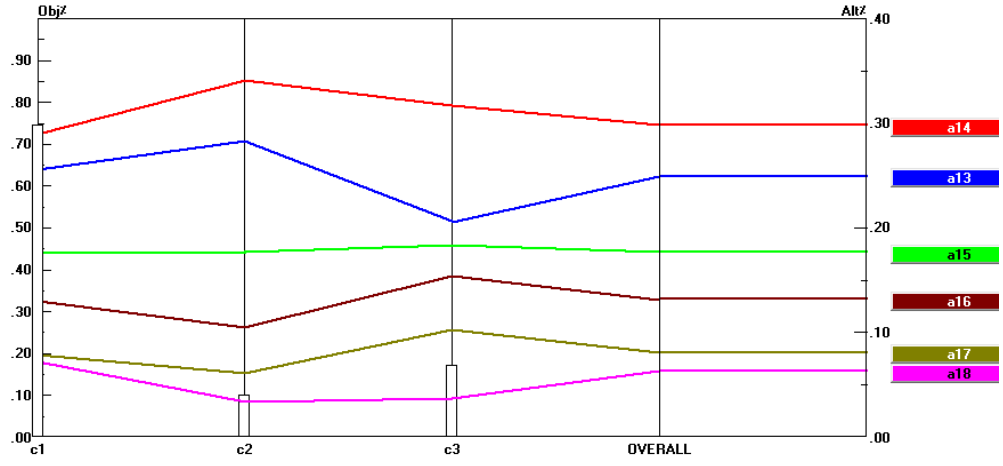
Fig. 7. The sensitivity analysis of indicators and suppliers for category B.